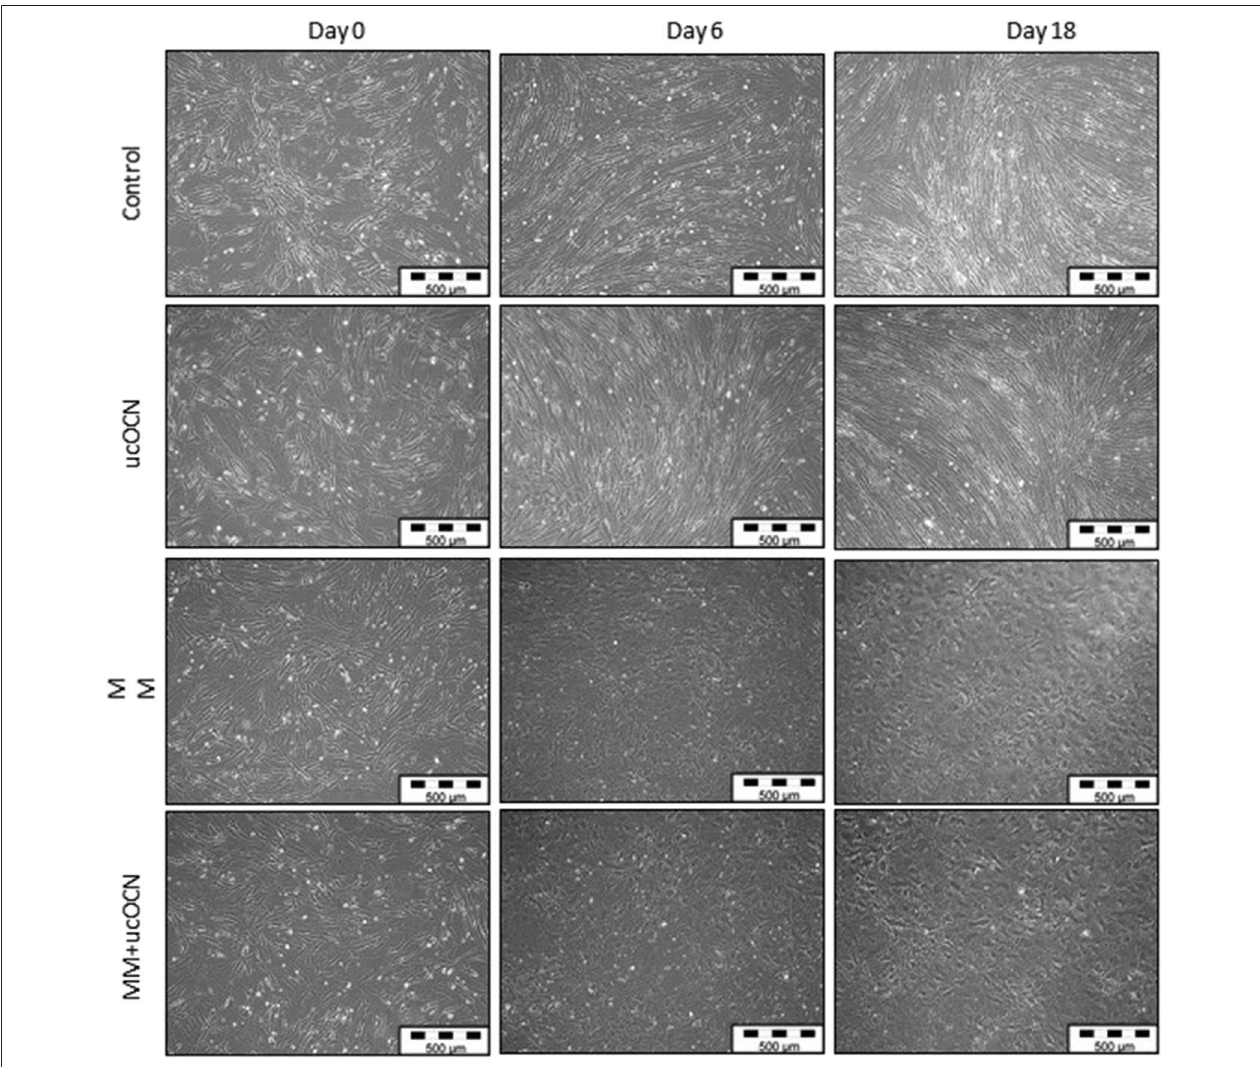
FIGURE 2 | Human aortic smooth muscle cells (SMCs) were cultured in usual growth media (control) with or without ucOCN (10ng/mL), or mineralisation inducing media (MM) with or without ucOCN (10ng/mL). Photos (10X magnification) taken at days 0, 6, and 18 visualized by light microscopcopy. Control media treated cells maintained a classical SMC phenotype while MM treated cells displayed a differentiated synthetic phenotype distinctly different to control cells.